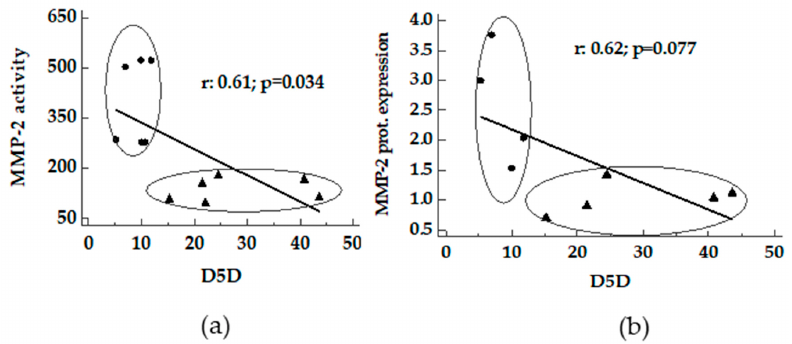
Figure 4. Correlation between D5D and MMPs in livers from MCD and Obese Zucker rats. Panels Figure 4 a and b , D5D activity index versus MMP-2 activity and MMP-2 protein expression. • : MCD rats; (cid:78) : Obese Zucker rats.